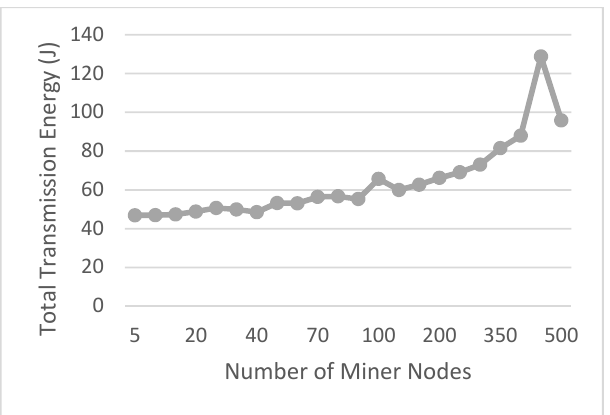
Figure 11. The total transmission energy vs. the number of miner nodes in the PoW model.